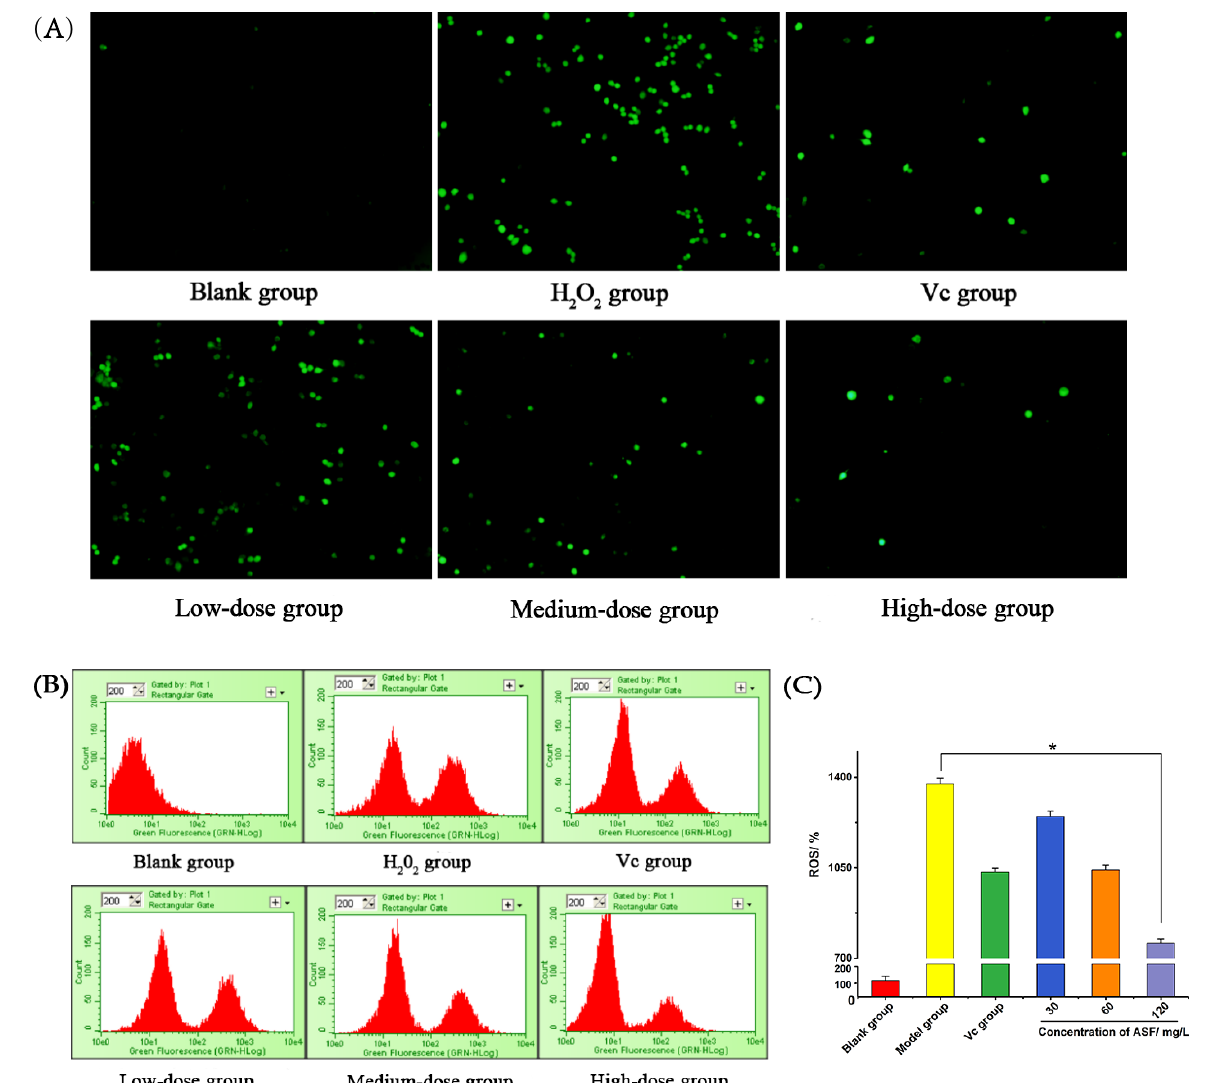
Figure 2. The detection of reactive oxygen species in RAW 264.7. ( A ) Representative image of DCFH-DA immunofluorescence staining. ( B ) Images of the relative content of ROS in cells measured by flow cytometry. ( C ) Quantitative analysis of Western blot data for DCFH-DA markers in RAW 264.7 cells treated with H 2 O 2 for 2 h. Note: For the comparison between the two groups, * indicates significant difference at p < 0.05.